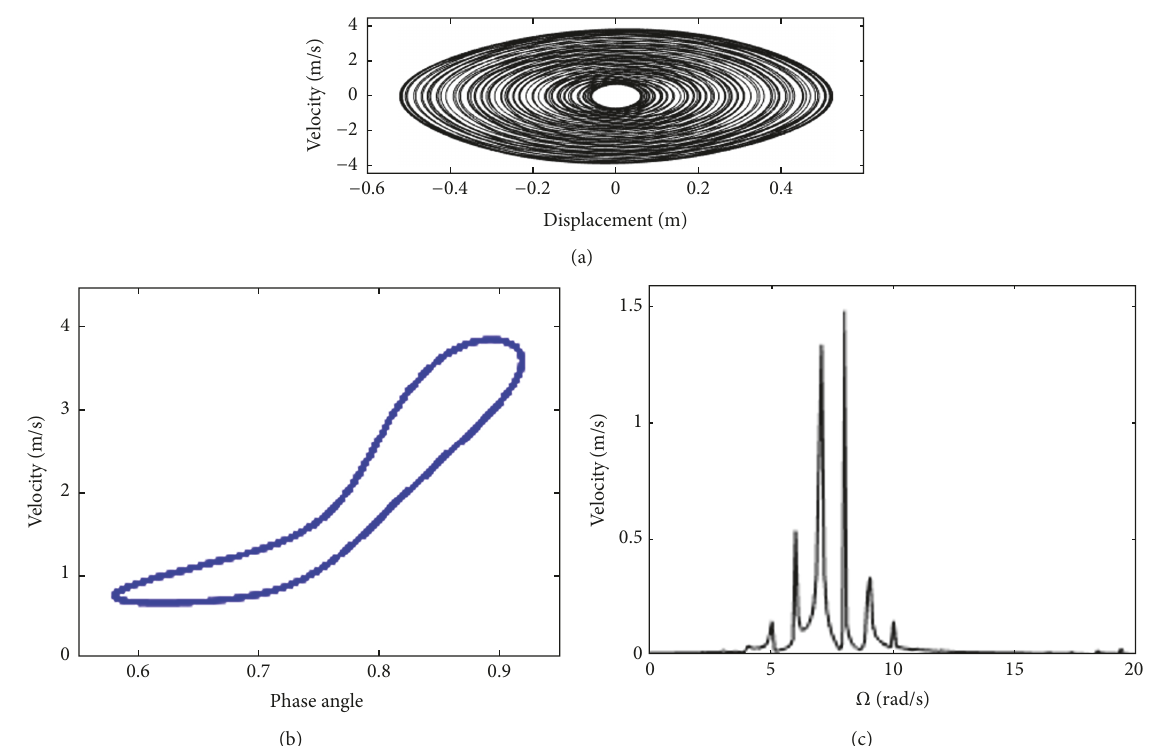
Figure 12: Quasiperiodic orbit at Ω = 8.05 rad/s: (a) the phase portrait, (b) the Poincar´e map, and (c) the frequency spectrum.